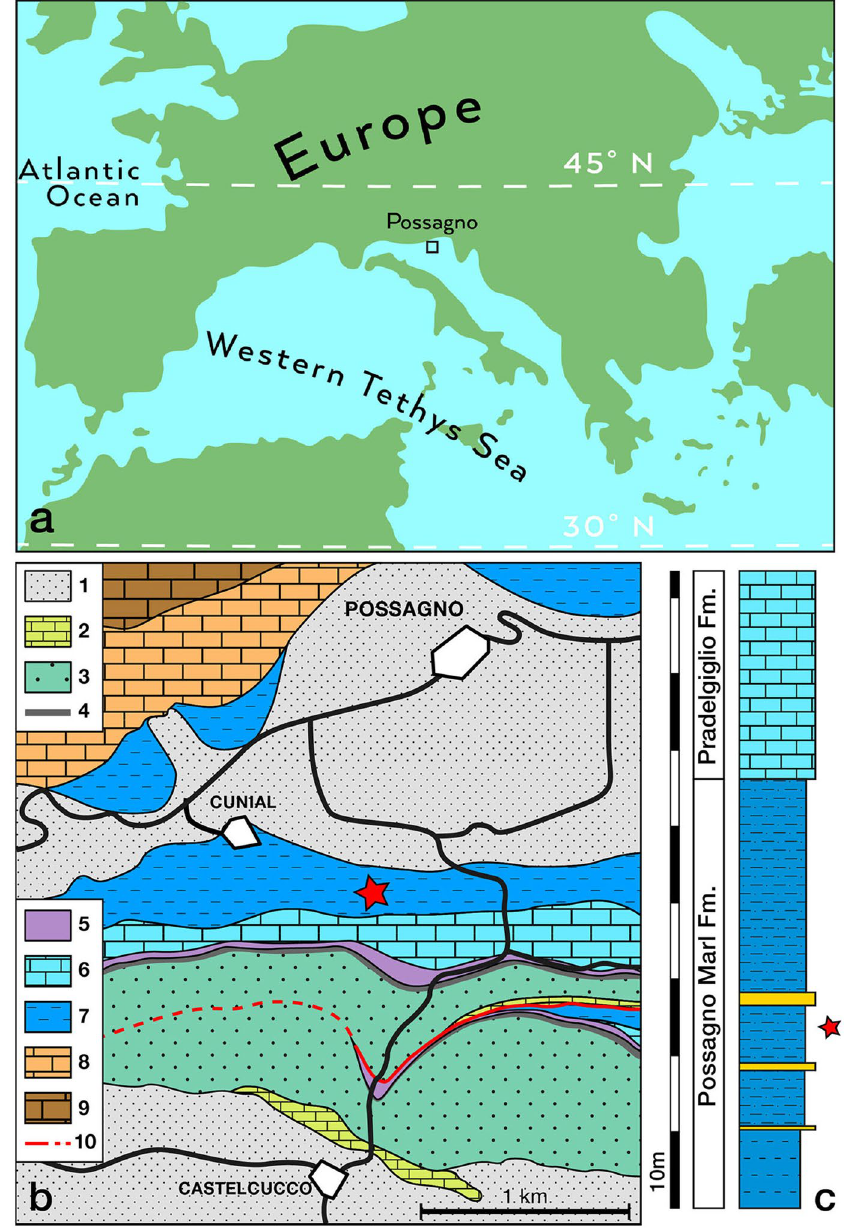
Figure 1. Location and geology of the Possagno area (northeastern Italy) and Vicetia bizzottoi fossil site. ( a ) Palaeogeography of western Europe with location of the study area. ( b ) Simplified geological map of the Possagno area with position of the Vicetia bizzottoi sp. nov. fossil site (red star). 1: Quaternary deposits; 2: Castelcucco calcarenite (Miocene); 3: glauconitic calcarenite (Miocene); 4: conglomerates (upper Oligocene- lower Miocene); 5: upper Possagno Marl Formation (upper Eocene); 6: Pradelgiglio Formation (upper Eocene); 7: Possagno Marl Formation (upper Eocene); 8: Scaglia Cinerea (middle-upper Eocene); 9: Scaglia Rossa (Upper Cretaceous-lower Eocene); 10: fault 75 . (c) Simplified stratigraphic log with position of the Vicetia bizzottoi sp. nov. bed (red star). Symbols for the Possagno Marl Fm. indicate marls and silty marls, in blue, and fine-grained sandstones, in orange. Maps created with Adobe Illustrator CC 2017 (21.0; https ://helpx .adobe .com/it/illus trato r/relea se-note/illus trato r-cc-2017-21-0-relea se-notes